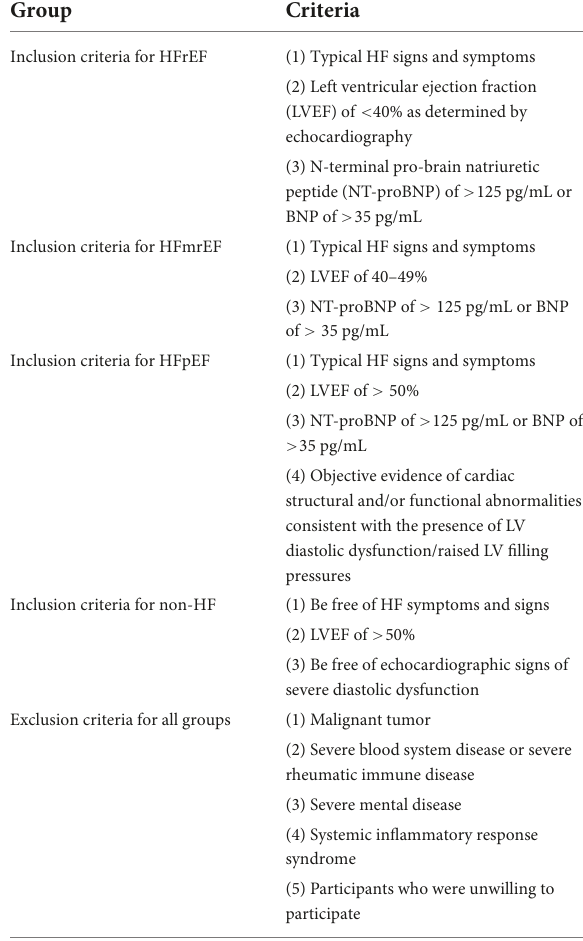
TABLE 1 The inclusion and exclusion criteria for enrolled